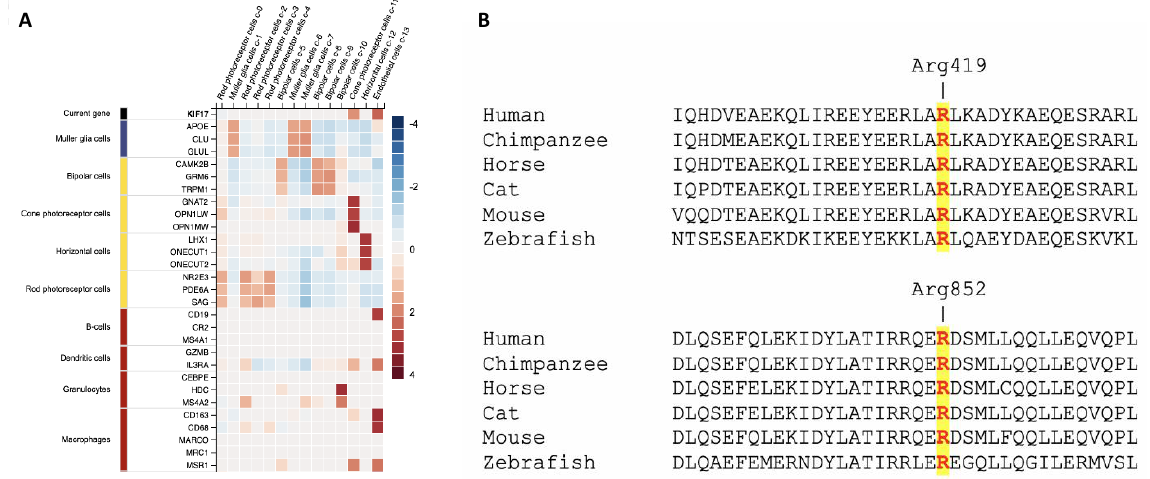
Figure 2. ( A ) KIF17 gene expression in the different eye-related cell types based on the Human Protein Atlas (www.proteinatlas.org, accessed on 21 April 2021). ( B ) Multiple alignment showing complete conservation across species and KIF17 homolog of the residues affected by the variants identified in this study (these variants are highlighted in yellow). Human KIF17 (UniProt: Q9P2E2), Chimpanzee KIF17 (UniProt: H2PY89), Horse KIF17 (UniProt: F6VCL8), Cat KIF17 (UniProt: A0A2I2V0D2), Mouse KIF17 (UniProt: Q99PW8), Zebrafish KIF17 (UniProt: